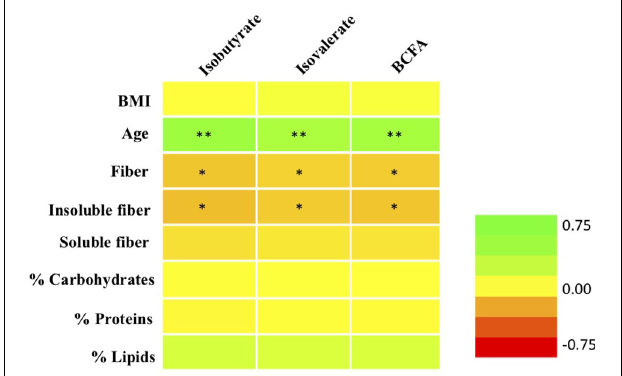
FIGURE 3 | Correlations between molar proportions of BCFA (total BCFA, isobutyrate, isovalerate) with age, BMI, and daily dietary intake of macronutrients and fiber. ∗ p < 0.05; ∗∗ p < 0.01. Green, positive correlations; orange-red, negative